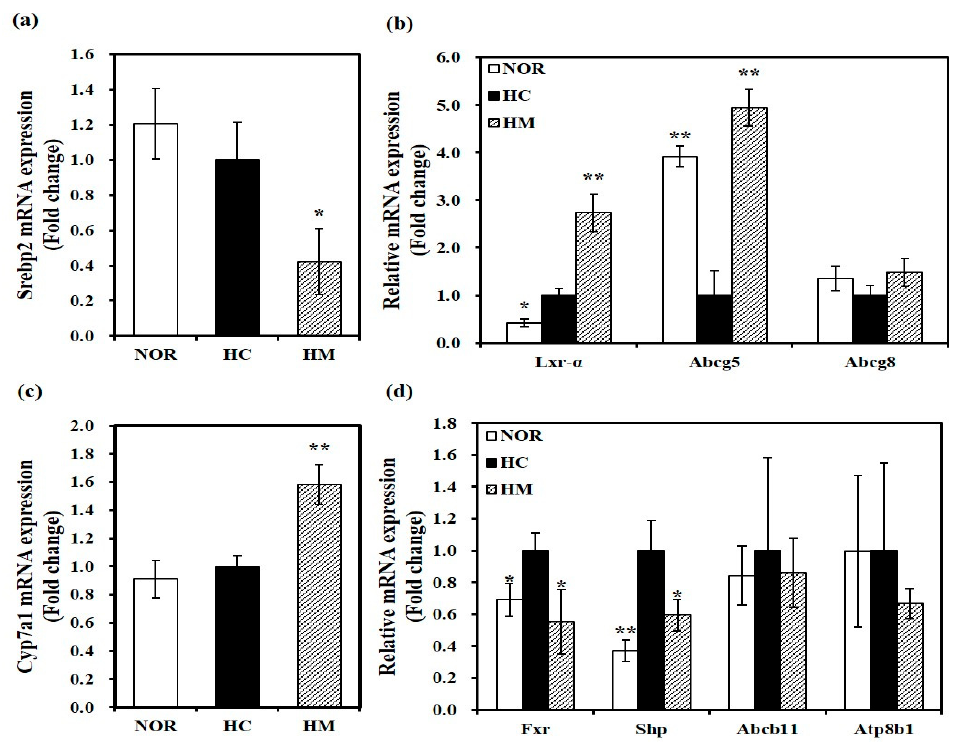
Figure 2. E ff ect of high hydrostatic pressure mulberry fruit extract on mRNA levels related to cholesterol homeostasis in the liver. Hepatic mRNA levels of Srebp2 ( a ); liver X receptor- α (Lxr- α ), ATP-binding cassette sub-family G member 5 (Abcg5), and Abcg8 ( b ); cholesterol 7 alpha-hydroxylase (Cyp7a1) ( c ); and farnesoid X receptor (Fxr), small heterodimer partner (Shp), and ATP-binding cassette subfamily B, member 11 (Abcb11) ( d ) were measured by RT-qPCR and normalized to β -actin. Data were expressed as fold change compared to the HC and expressed as mean ± SEM ( n = 6). * p < 0.05; ** p < 0.01 compared to the HC diet. NOR, normal diet; HC, high cholesterol / cholic acid diet containing 1% cholesterol and 0.5% cholic acid; and HM, HC + 0.4% high hydrostatic pressure mulberry fruit extract.